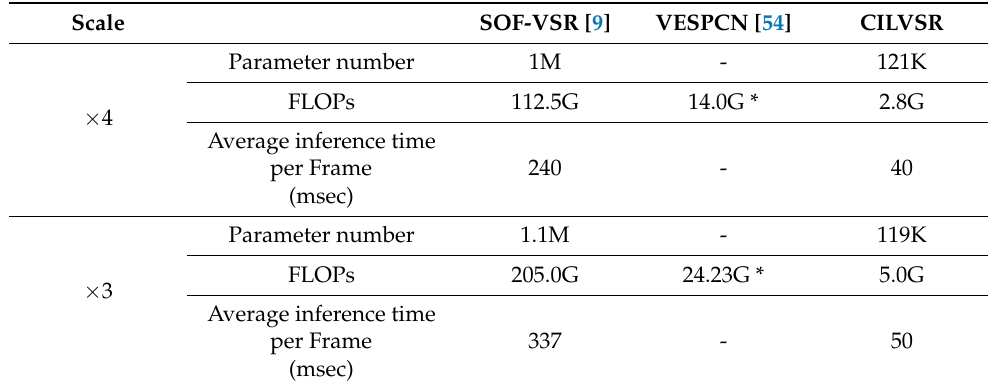
Table 8. Comparative result of parameter number, FLOPs, and average inference time of pro- posed method and other technique. The results marked with an asterisk (*) are sourced from the respective